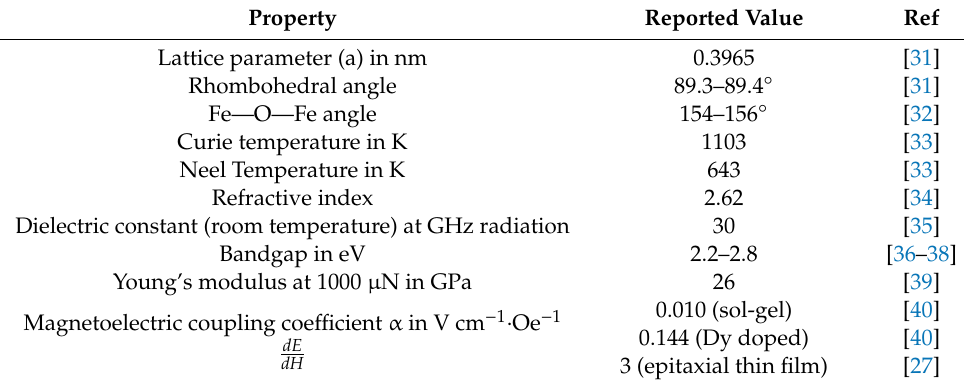
Table 2. Properties of Bismuth ferrite.